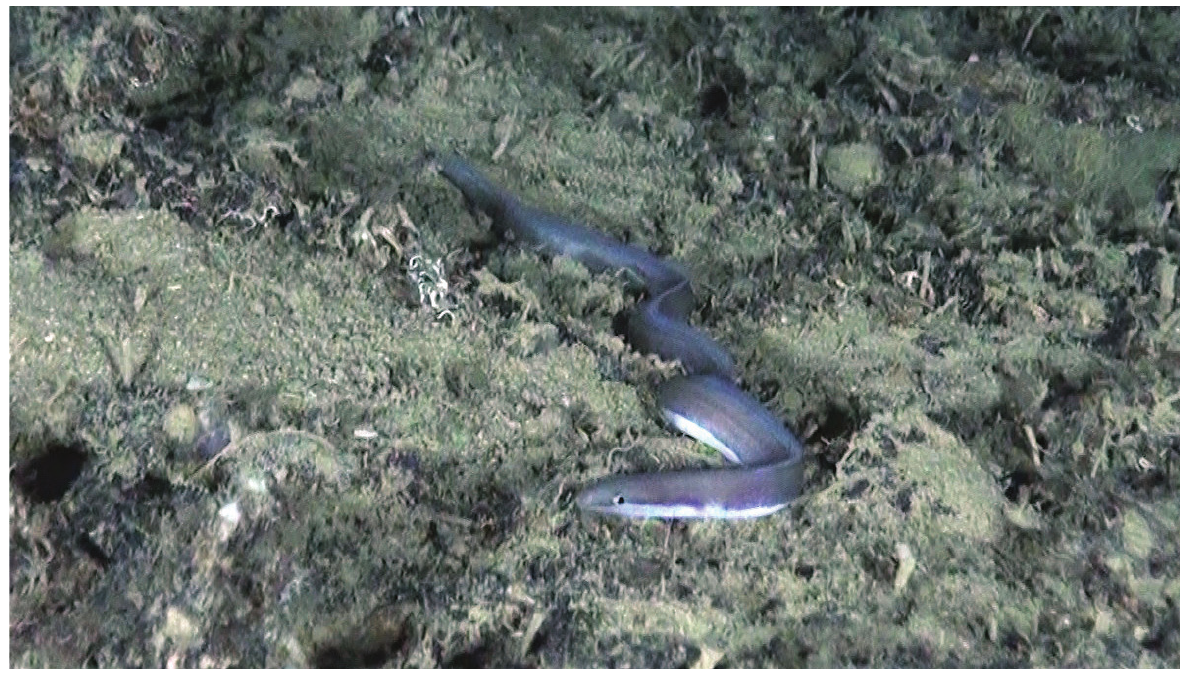
Figure 3. Image grab from ROV footage collected on 26 June 2016 at a depth of 458 m, (35º32.060′N, 014º13.220′E) showing an individual of Chlopsis bicolor . Image: OCEANA © LIFE BaĦAR for Table 3. Individuals of Grammonus ater and Gaidropsarus granti recorded from the LIFE BaĦAR for N2K marine benthic surveys.